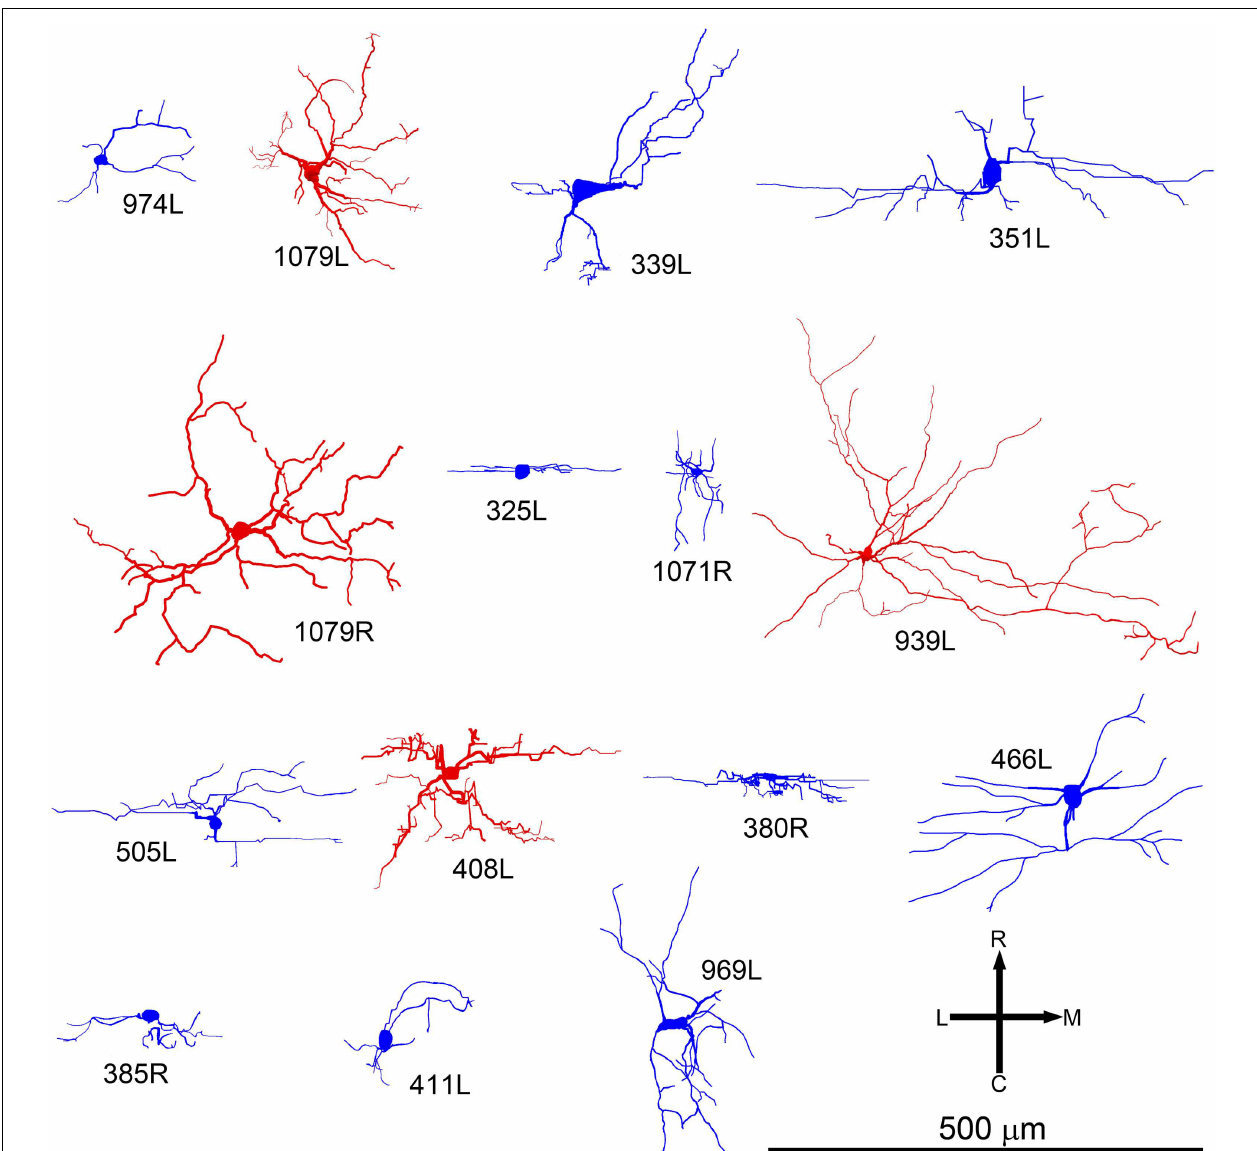
FIGURE 4 | Soma and dendrites of all the cells shown in the same tonotopic order as in Figure 2 but viewed in the horizontal plane. At this orientation many of the cells still have an elongated cylindrical shape (blue cells). Others have a more stellate appearance and are classed as disk cells